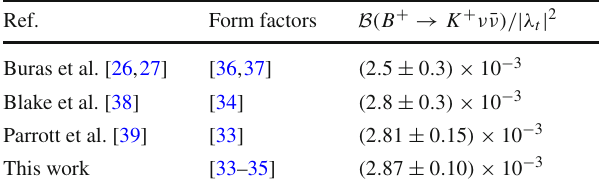
Table 1 SM predictions for B ( B + → K + ν ¯ ν)/ | λ t | 2 and the corre- sponding form factors used in the computation. Note that the non- negligible contribution proportional to G 4 the above results, cf. Sect.